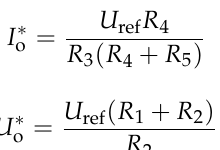
Figure 7. Schematic of APC system.